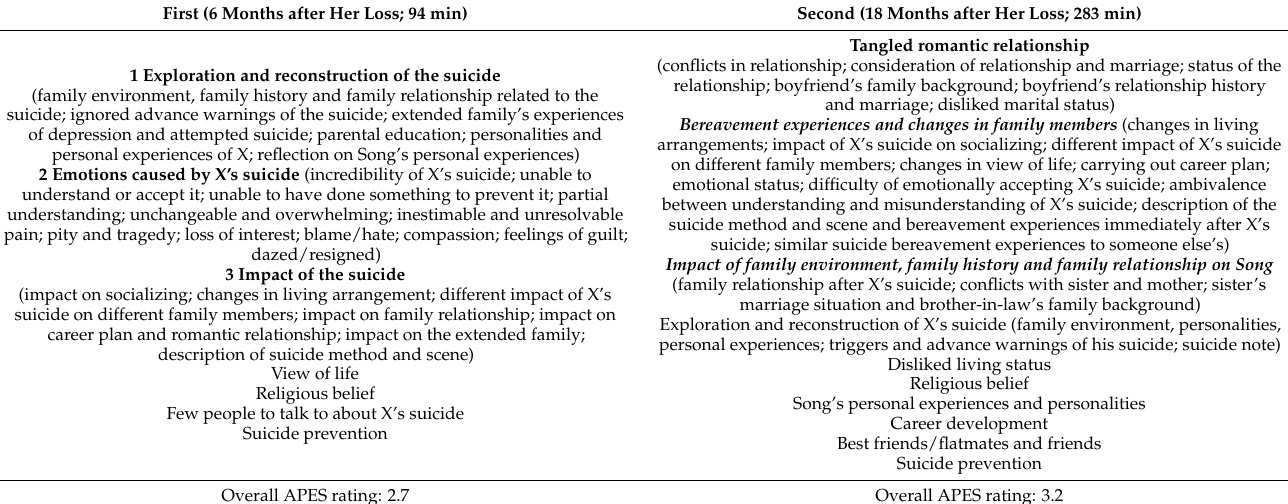
Table 2. Themes included in each of Song’s two